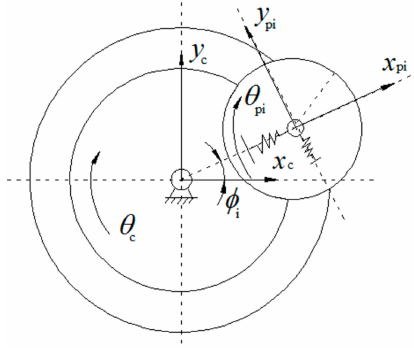
Figure 5. Planetary carrier